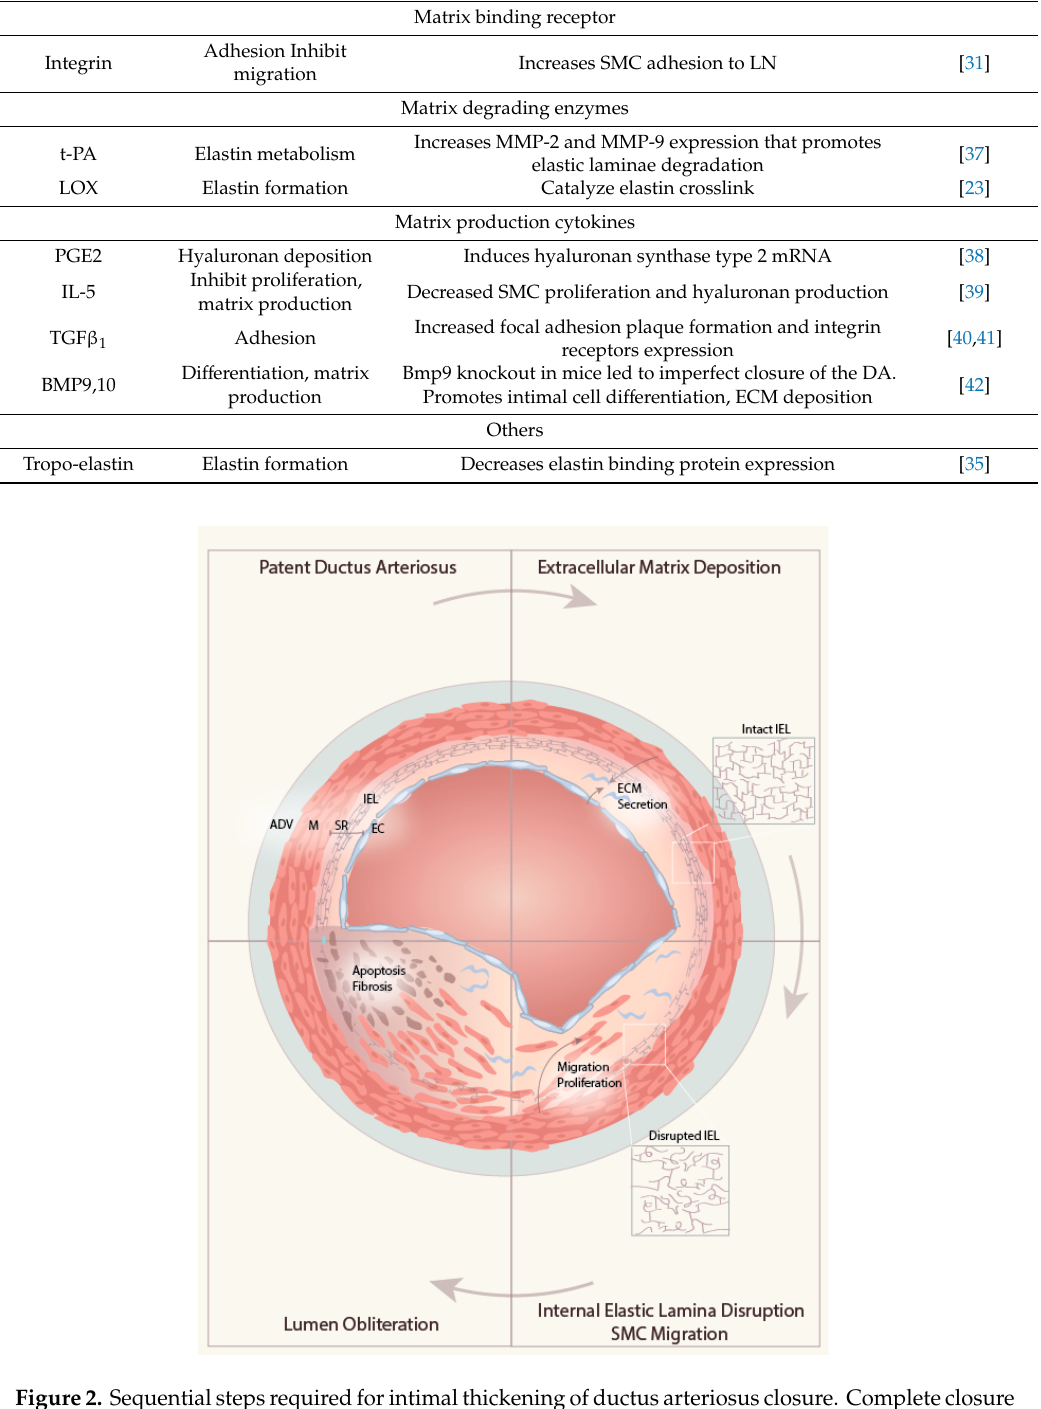
endothelial cell, IEL: internal elastic lamina, ECM: extracellular matrix. cell, IEL: internal elastic lamina, ECM: extracellular